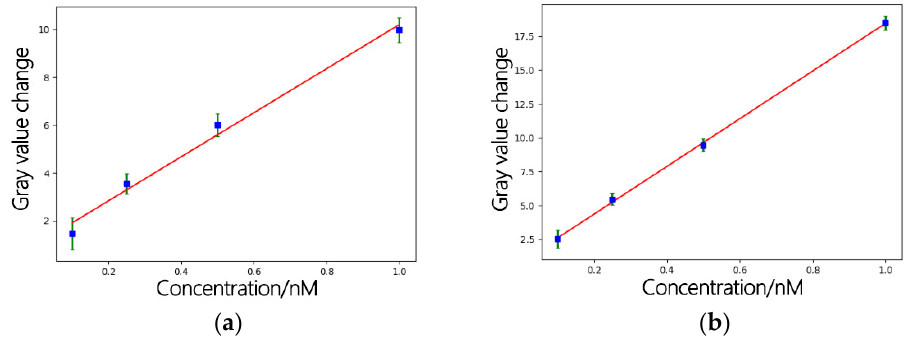
Figure 16. ( a ) The fitting curve between the gray value of the fluorescence image and the target molecular concentration before denoising; ( b ) the fitting curve between the gray value of the fluorescence image and the target molecular concentration after denoising.